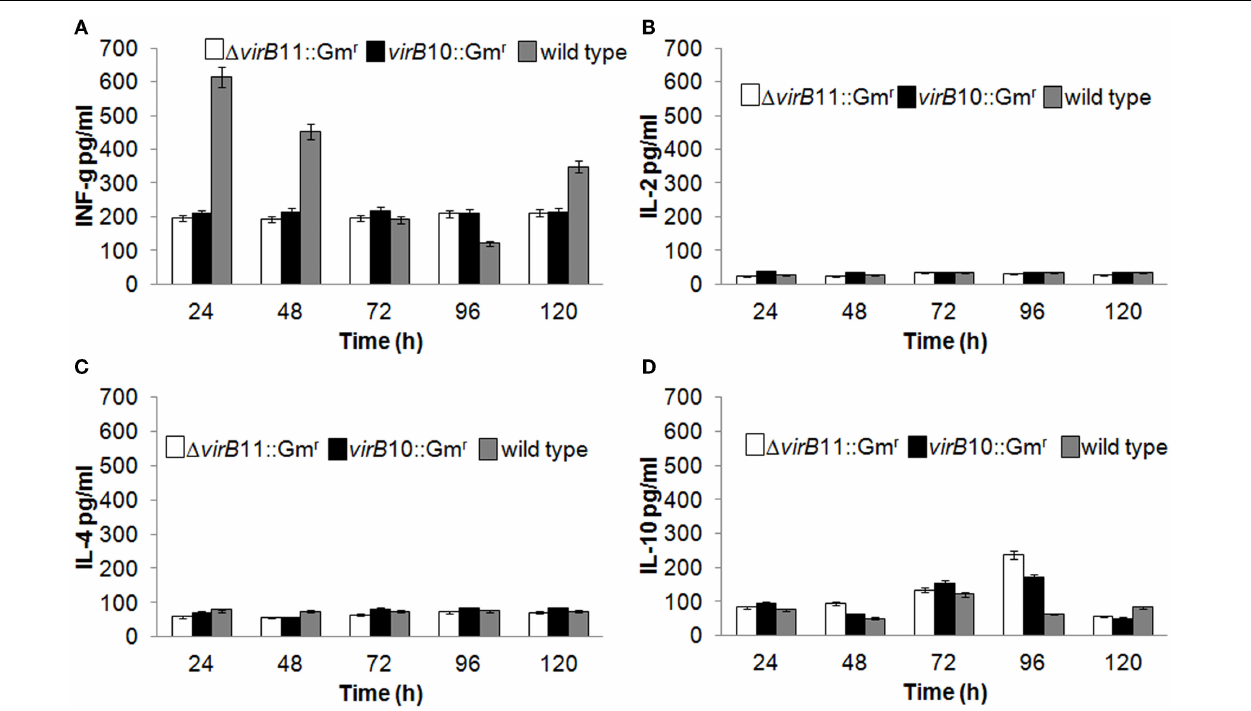
wild-type strain or concanavalin A as a positive control. Supernatants were harvested at 24, 48, 72, 96, and 120h and were then assayed for IFN- γ (A) , IL-2 (B) , IL-4 (C) , and IL-10 (D) production (pg/ml) at different times of stimulation using a multiplex suspension array system (Sigma Aldrich, St. Louis, MO,